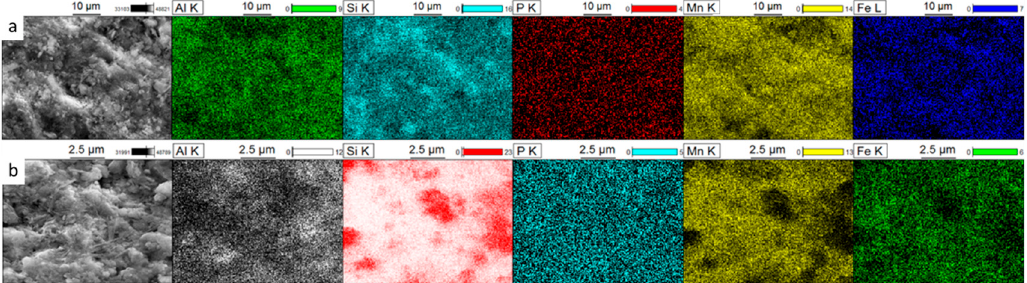
Figure 4. Element compositions in the surface of BFS1 samples detected with EDS: ( a ) before P adsorption; ( b ) after P adsorption.